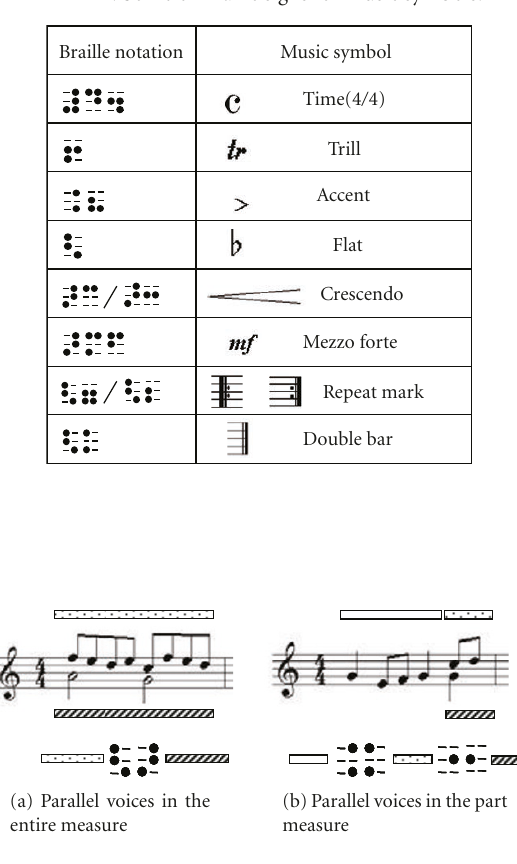
Figure 3: Braille representation of parallel voices. Each bar ( , , ) denotes Braille representation corresponding to a voice in the sta ff notation. In (a), each voice is consecutively con- nected by the full-measure in-accord sign ( ). In (b), parallel voices are specified by the measure-division sign ( ), and then each voice is connected by the part-measure in-accord sign ( ).